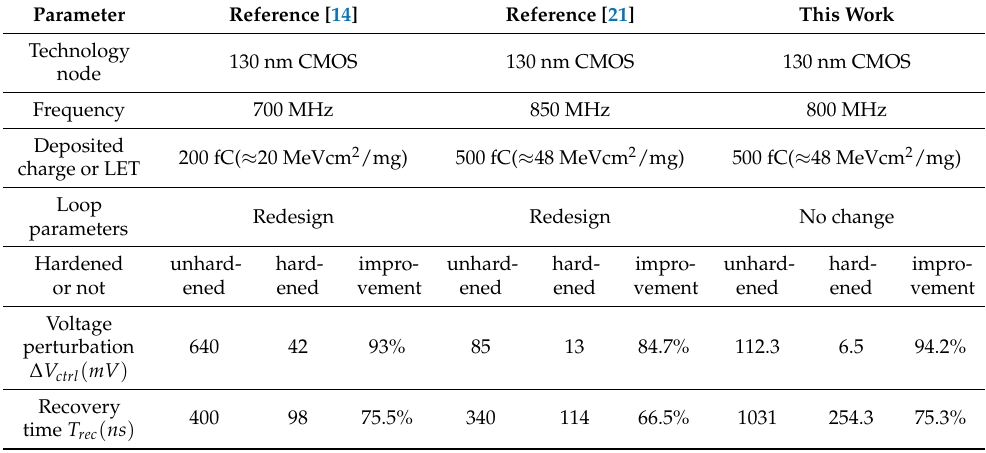
Table 2. Comparison with other